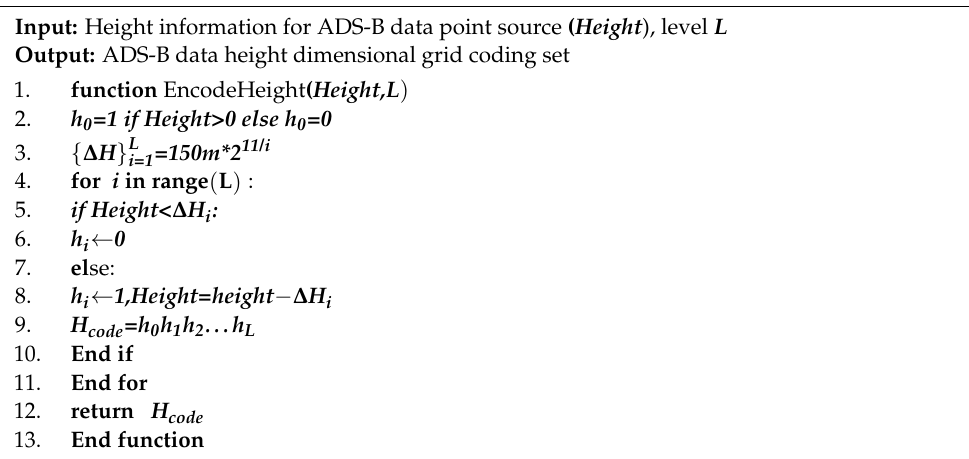
Algorithm 2 Grid set generation algorithm for height